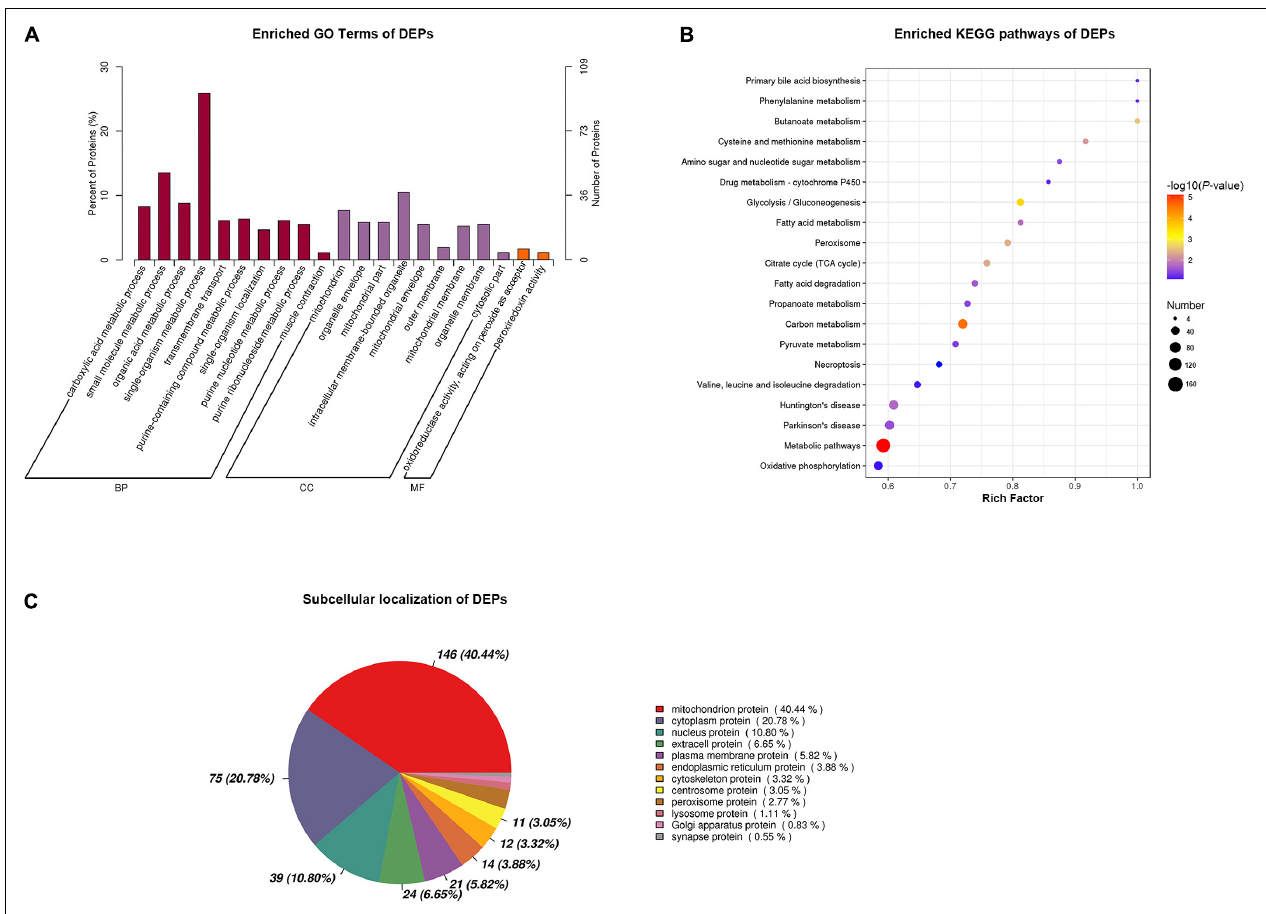
FIGURE 4 | Functional annotation of differentially expressed proteins (DEPs) between slow-twitch and fast-twitch muscles in P. dentex . (A) Gene Oncology (GO) analysis of DEPs. Dark purple bars represent biological process (BP); red bars represent cellular components (CC); orange bars represent molecular function (MF). (B) The top terms of Kyoto Encyclopedia of Genes and Genomes (KEGG) signaling pathway enrichment for DEPs. The rich factor of the x-axis indicates the number of enriched proteins associated with the given KEGG term divided by the total number of input proteins. The specific terms are plotted along the y-axis. The size of the colored dots indicates the number of significant DEPs associated with each corresponding term. The color of each dot indicates the -log10 ( p -value) for the corresponding term. (C) Subcellular localization analysis for DEPs. The data in the pie chart present the subcellular positioning ratio of the